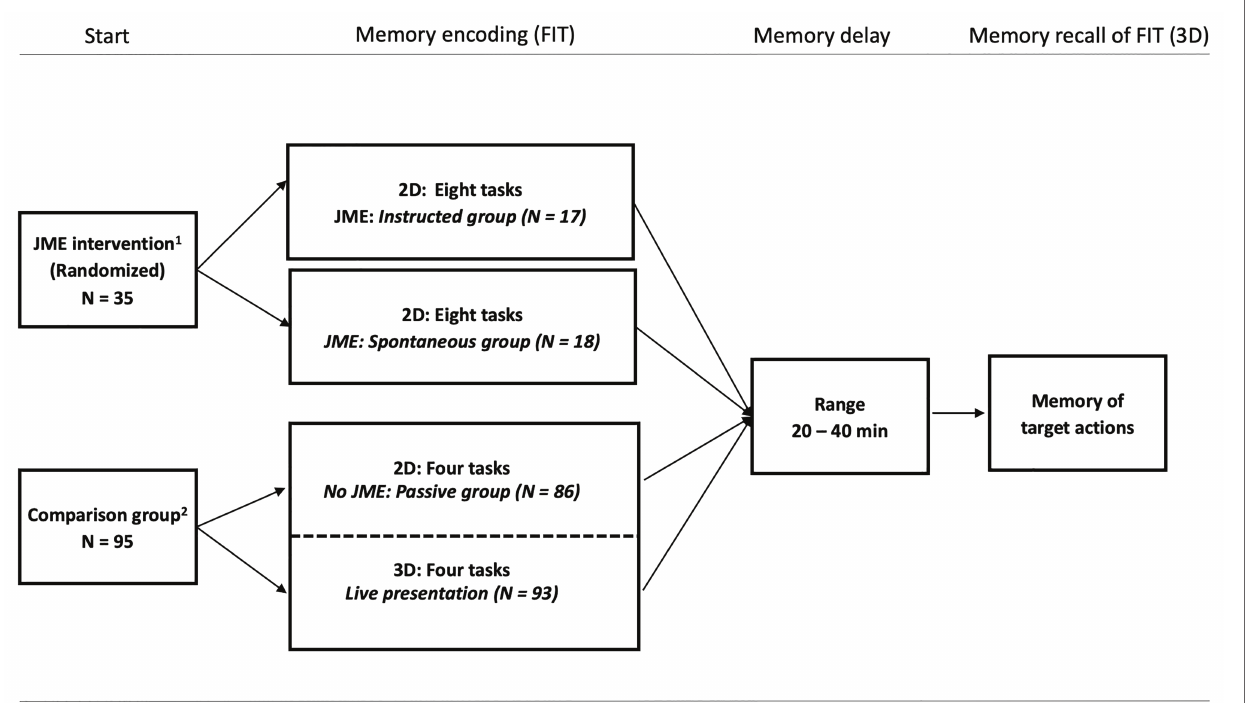
FIGURE 1 | The figure displays the overall design of the procedure and the groups included: The two JME intervention groups watching the complete Frankfurt Imitation Test (FIT) on a tablet and the children in a separate study used for comparison purposes being presented with half the same test (four items) either passively on a computer screen (2D) or live